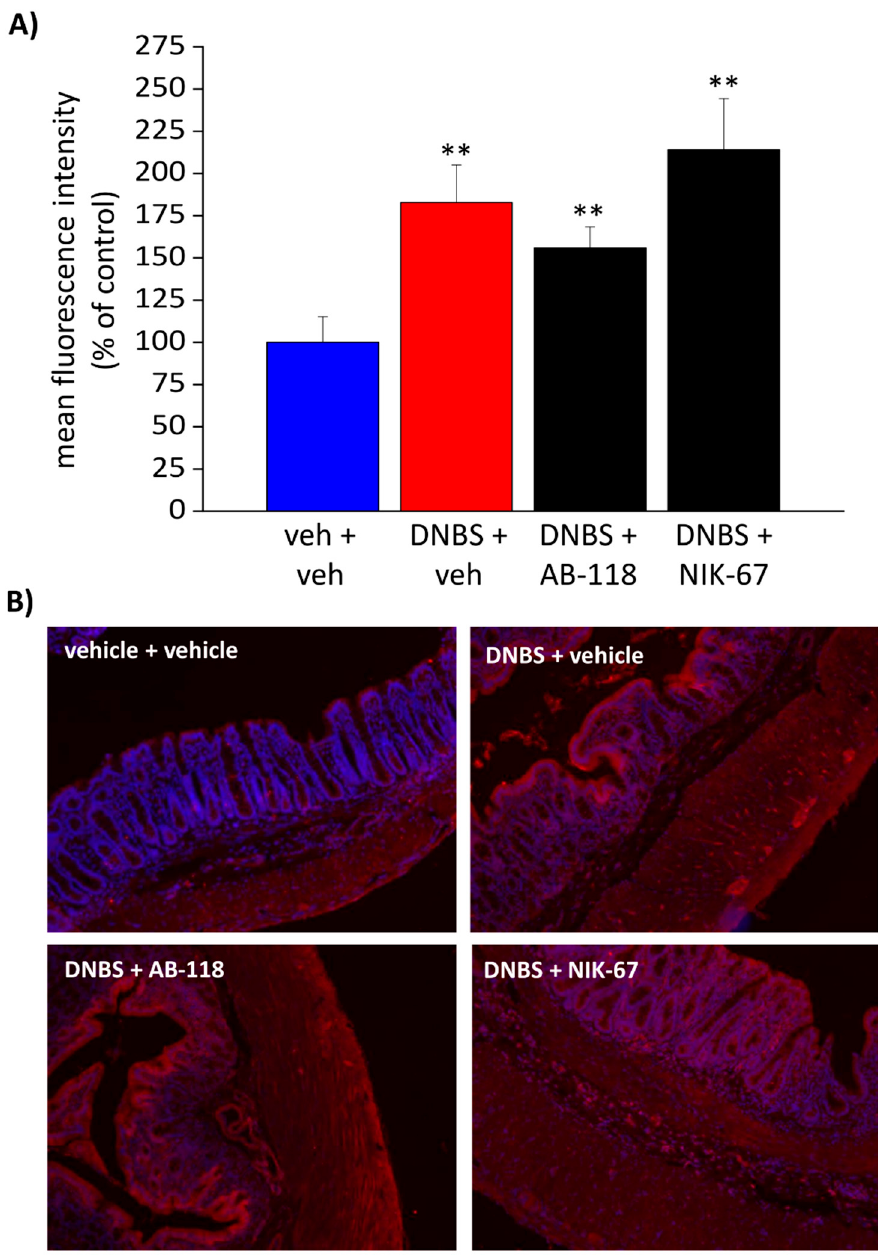
Figure 6. Effect of DNBS injection and AB-118 or NIK-67 administration on CA IV expression in colon mucosa. The distribution of CA IV on colon sections was evaluated by immunofluorescence on tissue sections. The mean fluorescence intensity relative to the entity of CA IV expression in the mucosa was expressed as a percentage of the control ( A ). Representative images of the colon mucosa were reported (scale bar: 10×; B ). The values are the means ± SEM of the measurements of individual animals (at least five images each) from the different experimental groups. ** p < 0.01 vs. vehicle + vehicle group.